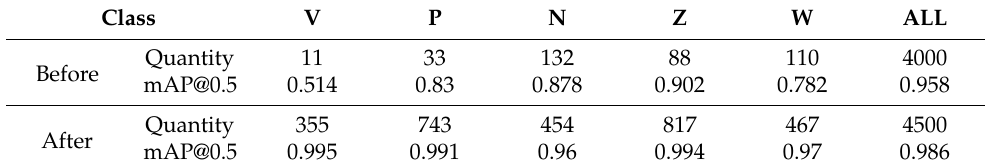
Table 4. Sample category and detection accuracy before and after small sample class